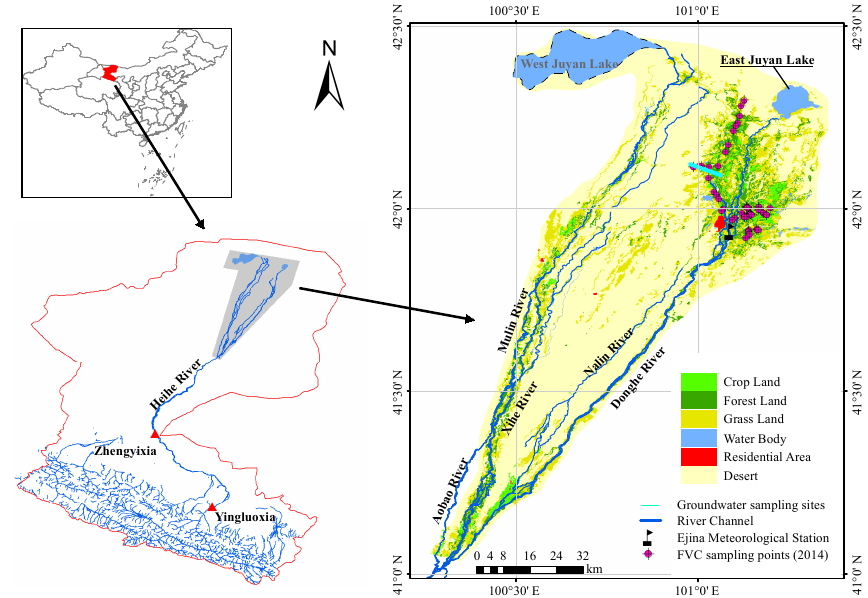
Figure 1. Location of the Heihe River Basin and Ejina Oasis. The enlarged land-use map was modified from Hu’s results; Hu et al. (2015b).